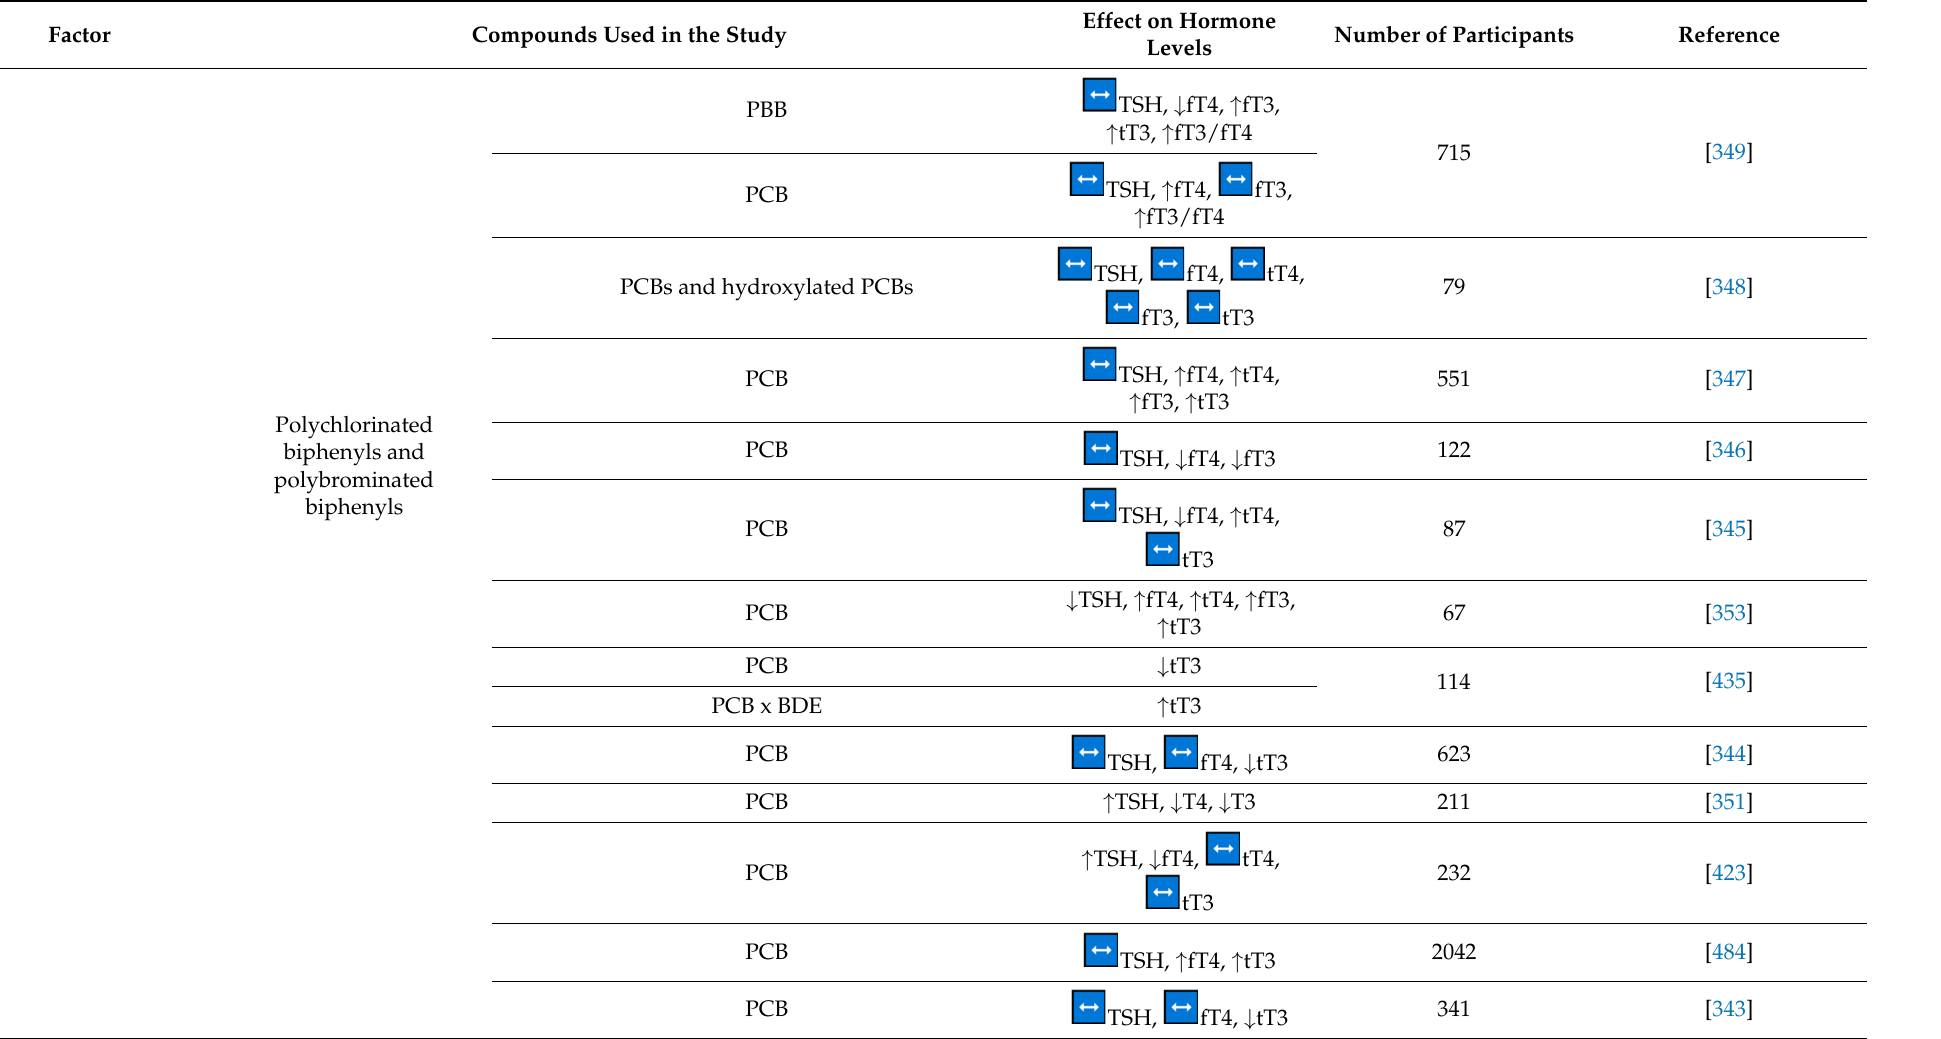
Table 2. Effect of pollutants on thyroid-stimulating hormone, thyroid hormone and thyroglobulin levels in healthy individuals. Factor Compounds Used in the Study